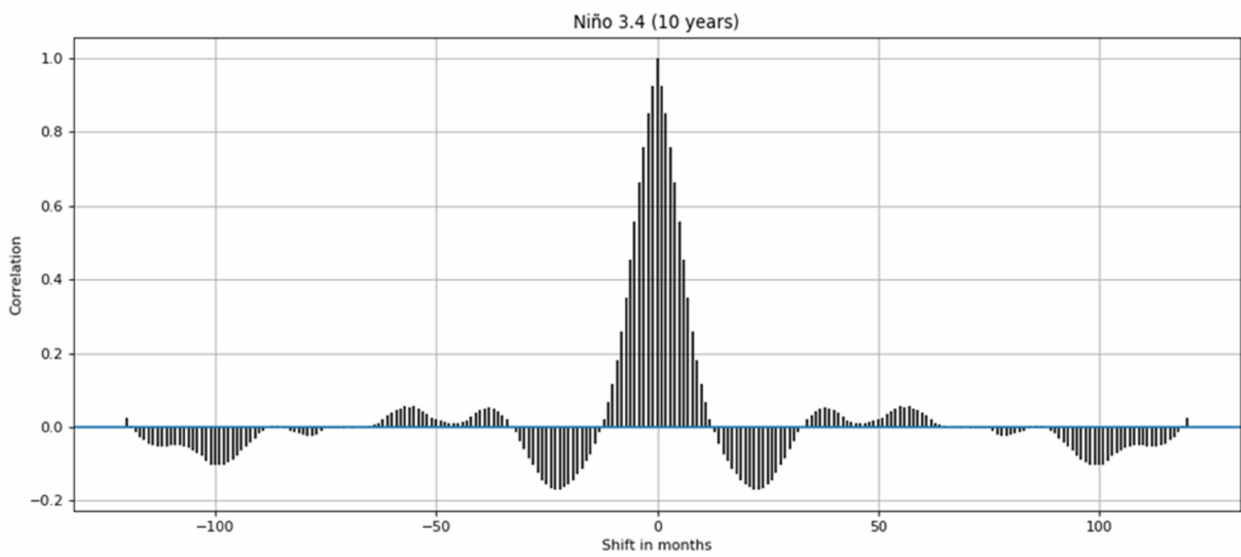
Figure 6. The autocorrelogram of the Niño 3.4 index.